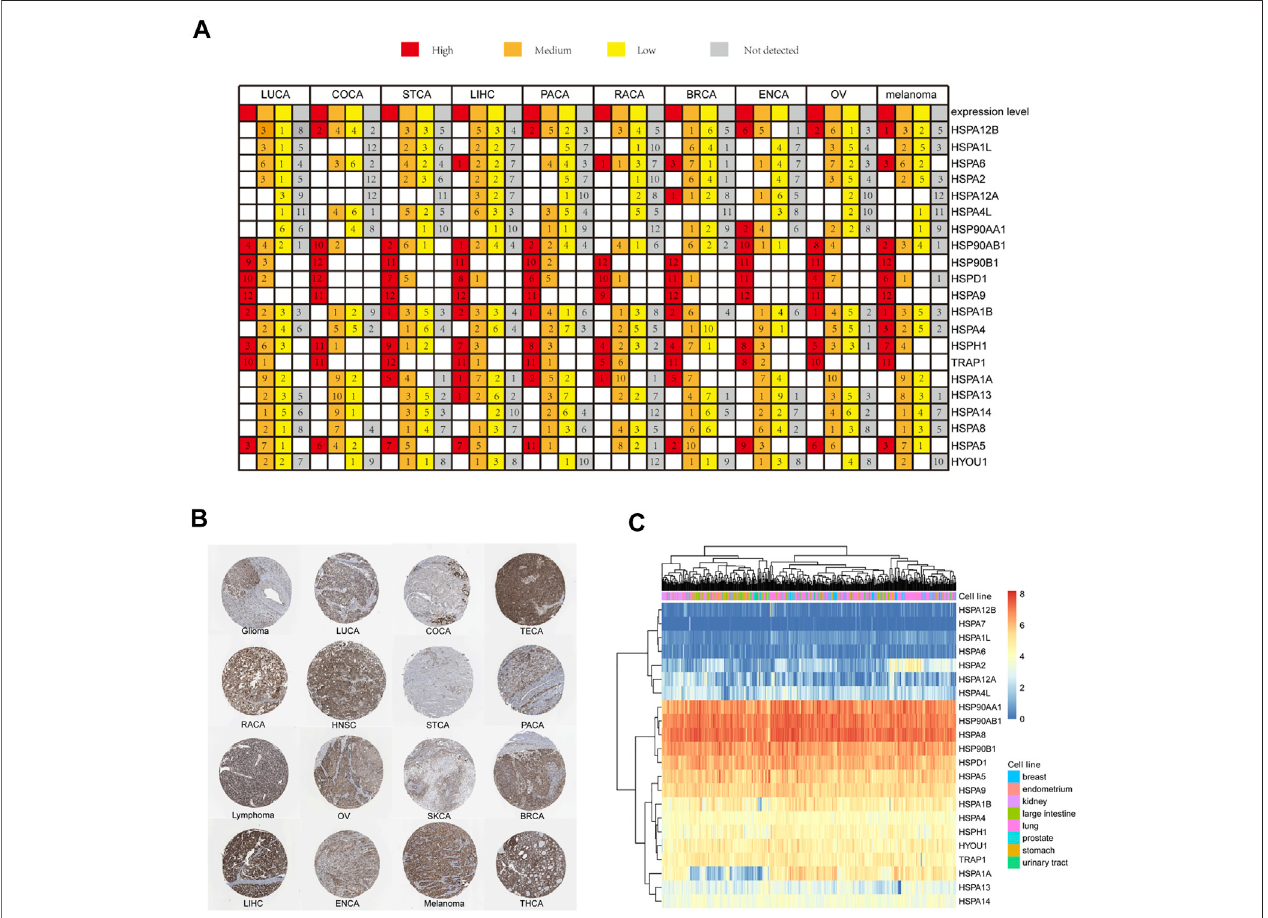
FIGURE2| HSPexpressionsatproteinandcelllevel. (A) HSPfamily membersproteinexpressionin10typesofcancers.Eachgeneexpression inonecancerwas divided into four groups of high expression (red color), medium expression (orange color), low expression (yellow color) and not detected (grey color). (B) The immunohischemistry staining results of HSPA9 protein in 16 types of cancers in The Human Protein Atlas database. (C) Expression pro fi le of HSPs family in cell lines in the CCLE database. Expression increased gradually from blue color to red color. CCLE, Cancer Cell Line Encyclopedia; LUCA, lung cancer; COCA, colorectal cancer; TECA, testis cancer; RACA, renal cancer; HNSC, head and neck cancer; STCA, stomach cancer; PACA; pancreatic cancer; OV, ovarian cancer; SKCA, skin cancer; BRCA, breast cancer; LIHC, liver cancer; ENCA, endometrial cancer; THCA, thyroid